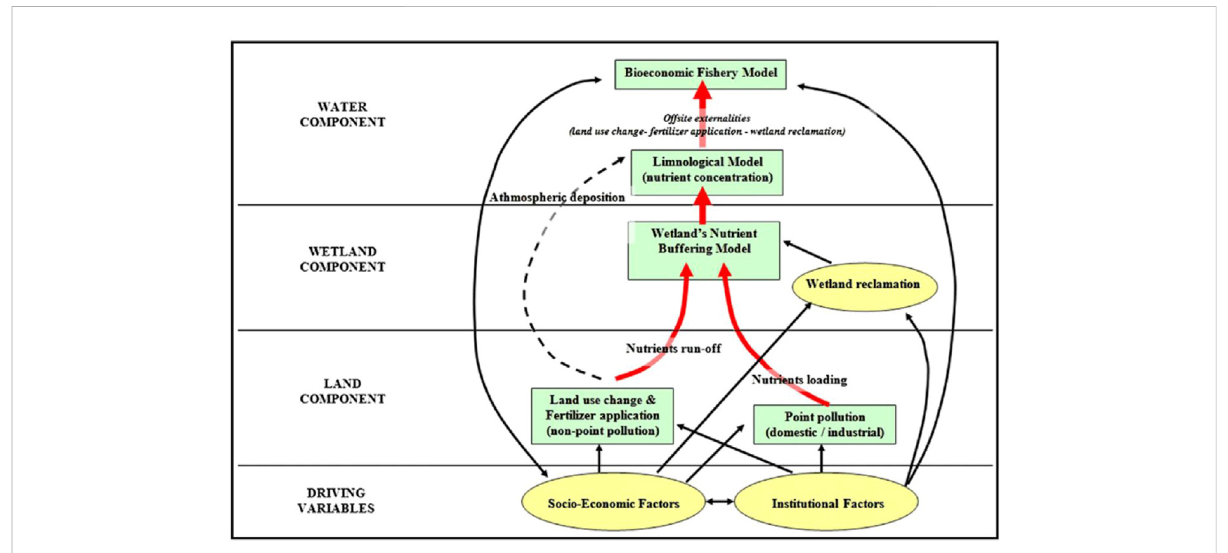
Logical framework of a valuation model, adapted from Simonit and Perrings (2011).